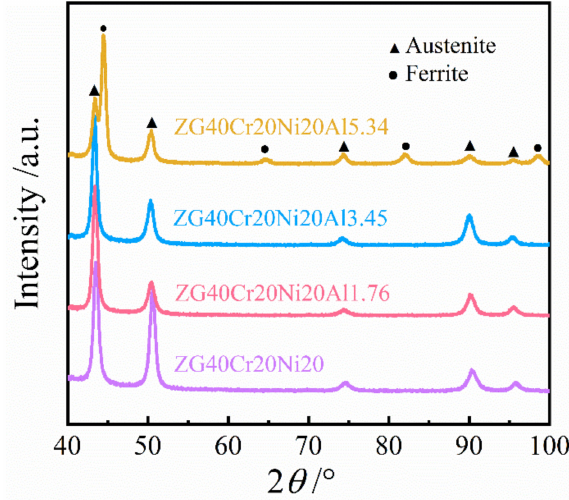
Figure 2. X-ray di ff raction (XRD) patterns of cast